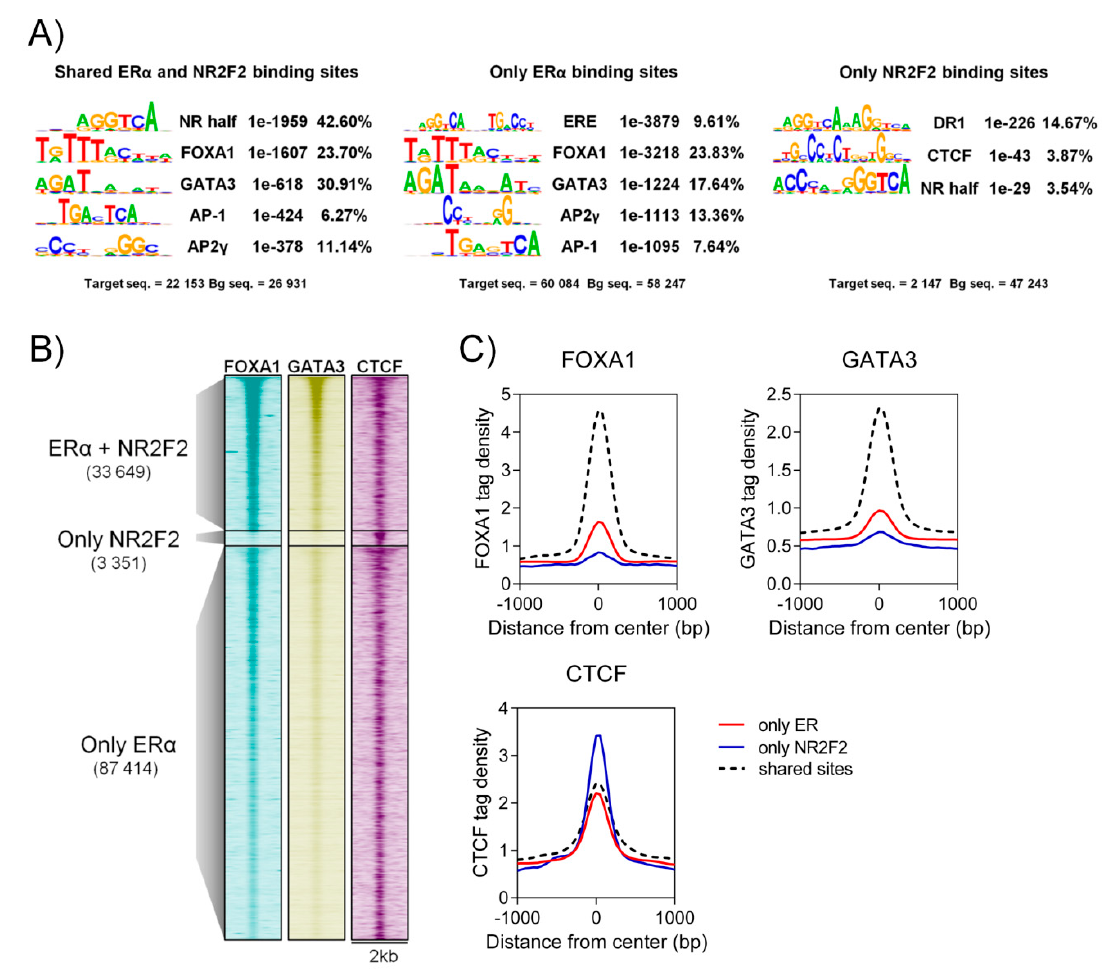
Figure 3. Co-factors at shared ER α and NR2F2 and individual binding sites in MCF-7. ( A ) Motif enrichment analysis at shared and individual ER α and NR2F2 binding sites. Motif logo, motif name, p -value and percent of target are represented. ( B ) Heatmap and ( C ) histograms represent the ChIP-seq signal intensities of FOXA1, GATA3 and CTCF at shared and individual binding sites in MCF-7